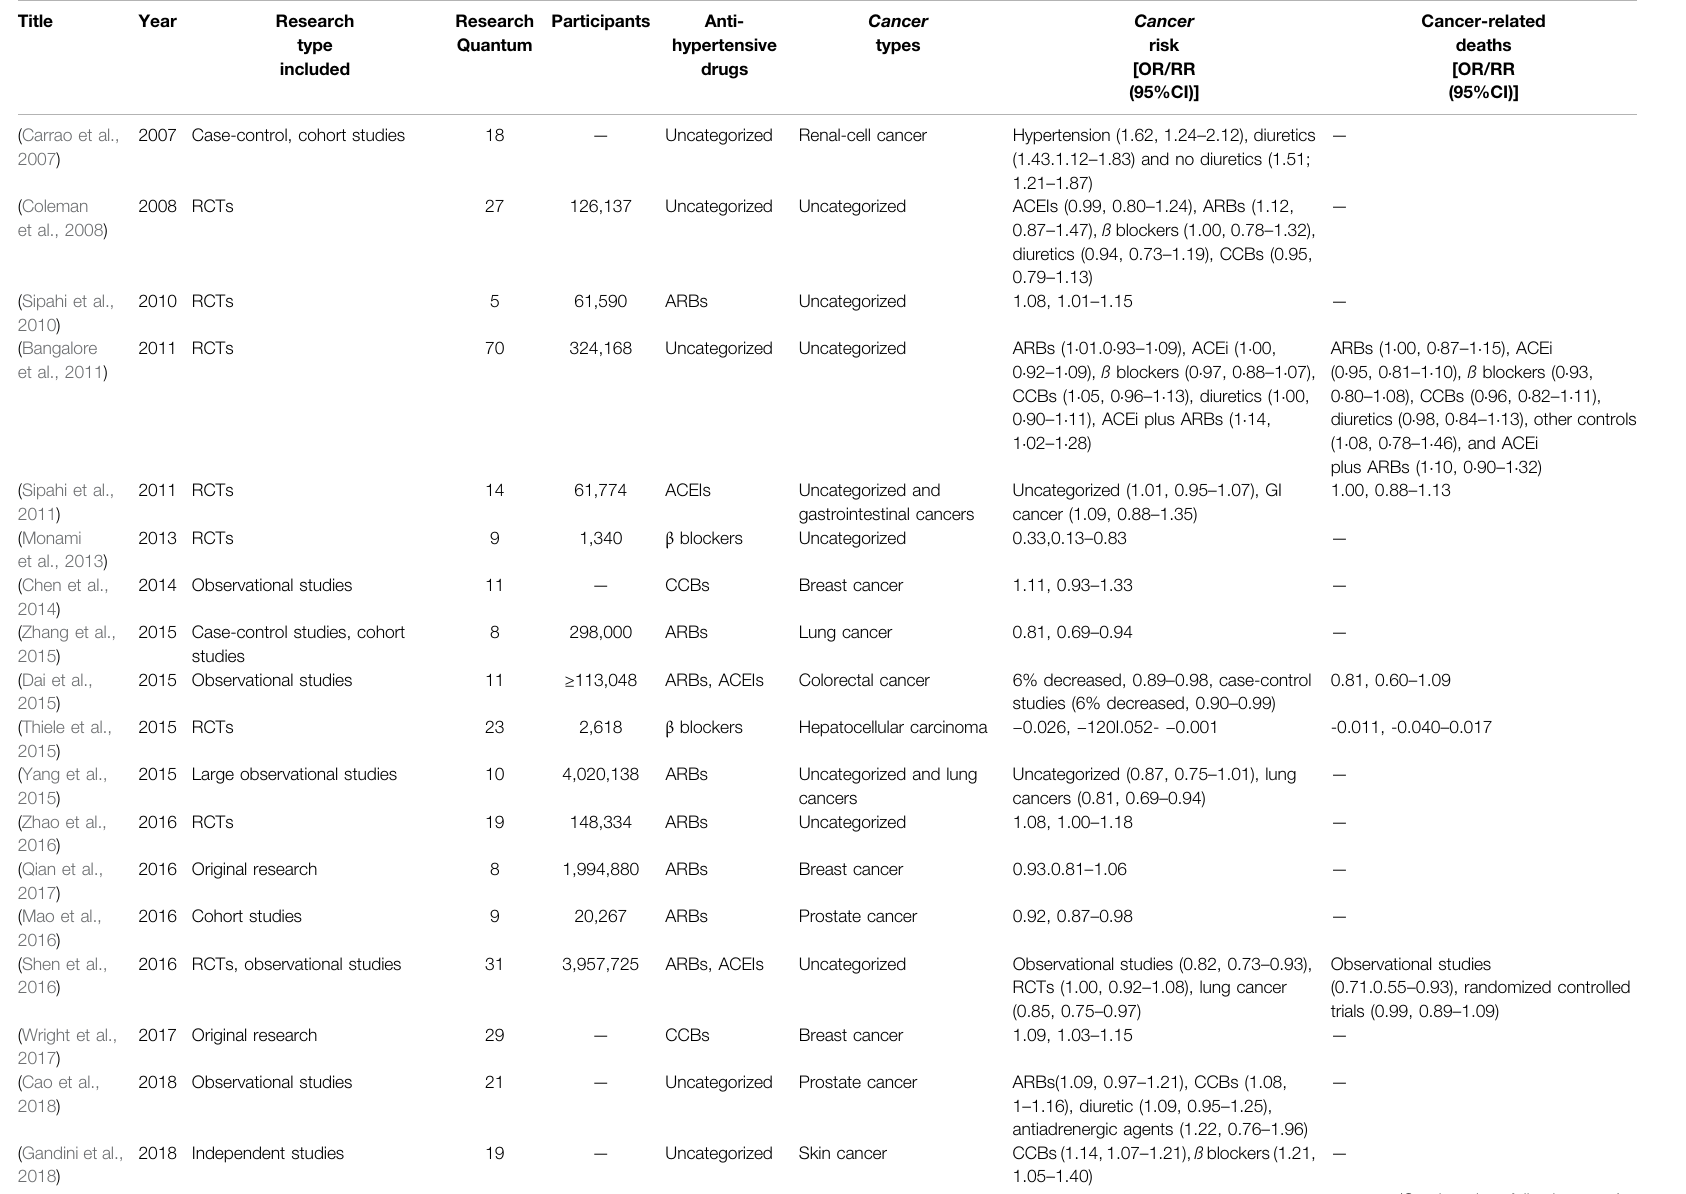
TABLE 1 | The systematic reviews and meta-analyses of antihypertensive drugs and cancer risk and cancer-related